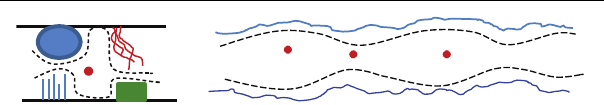
FIGURE 1 | Suspended particles in a confined environment. Left: the presence of vesicles, organelles and filaments affect molecules and proteins dynamics by reducing the accessible space. Right: suspended particles in a rough channel are affected by the varying-effective-section of the